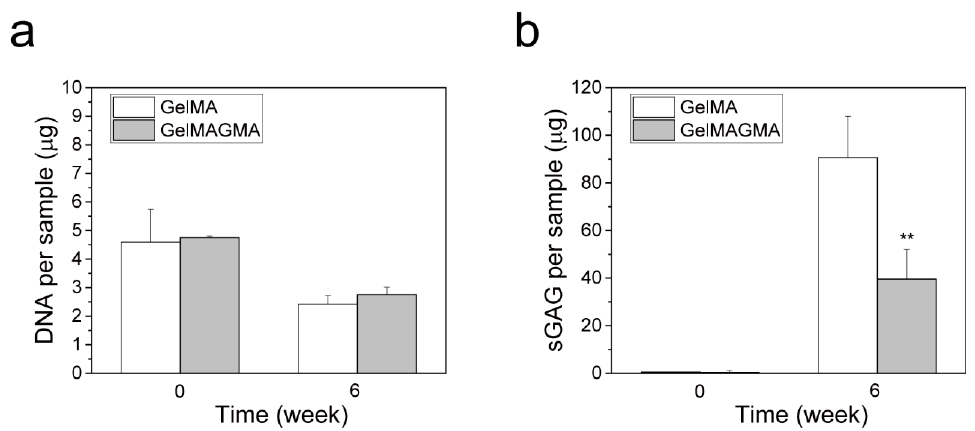
Figure 5. DNA amount ( a ) and sGAG content ( b ) in GelMA and GelMAGMA hydrogels before implantation (0 week) and after in vivo implantation for six weeks (6 week). Means ± SD, N = 4. ** p < 0.01.